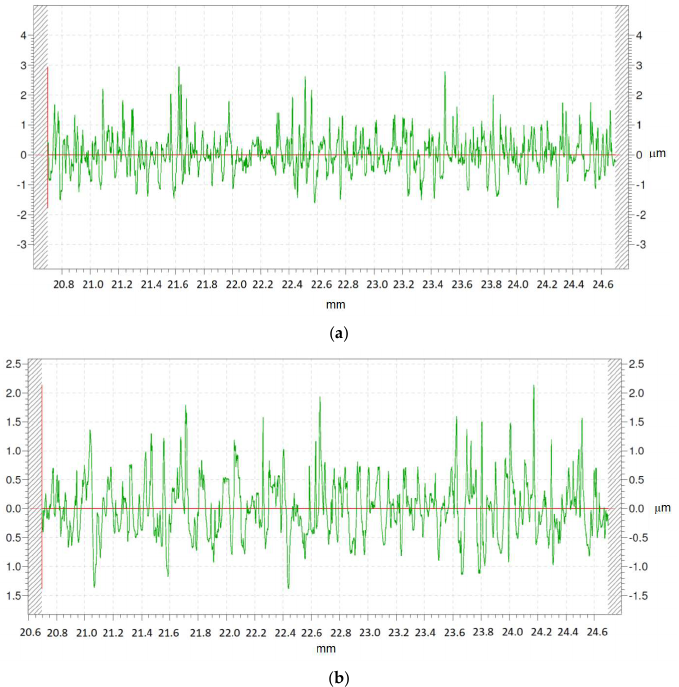
Figure 6. Roughness profiles of: ( a ) Experiment 9, obtained with high pressure of 600 N/cm 2 ; ( b ) Experiment 11, obtained with low pressure of 400 N/cm 2. Higher peaks (up to 3 µm high) and lower valleys (up to 1.8 µm deep) are obtained with high pressure (Figure 6a) than with low pressure (Figure 6b). This suggests that higher pressure leads to deeper scratch marks on the workpiece’s surface [36]. On the other hand, in rough honing processes pressure is known to affect not only roughness but also the cylindricity error of the parts [37]. From the experimental values obtained after the design of experiments deployed in Table 2, a fuzzy inference system was developed for each of the response variables. Once these FISs were obtained, ANFISs were employed to adjust the values of the membership functions in order to obtain greater precision in the models thus obtained. The results obtained are shown below. As can be observed, Figure 7 shows the response surface plots for (Rk), for different pairs of variables, which have been obtained by using the ANFIS, where two independent variables are varied within their variation levels while the rest are kept at their central values.